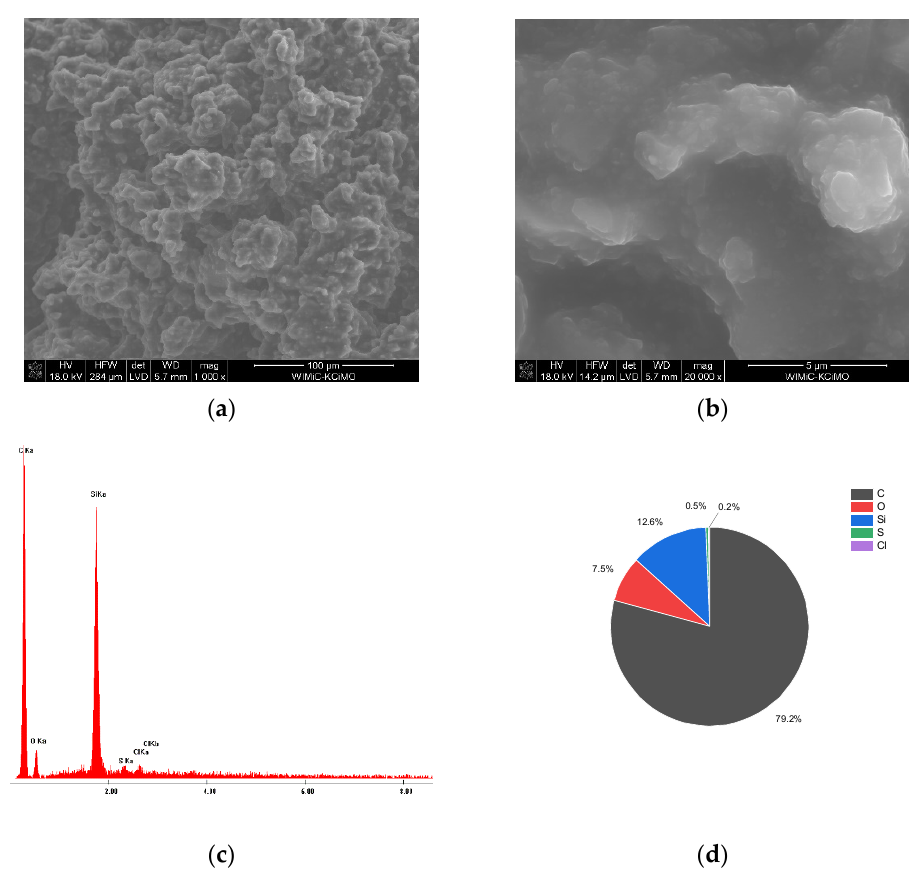
Figure 3. ( a , b ) SEM micrographs of GC n /PDMS paste taken at different magnifications: ( a ) 1000× g , ( b ) 20,000× g . ( c ) EDX spectrum of GC n paste, and ( d ) percentage (m/m) composition of GC n paste calculated from EDX data.